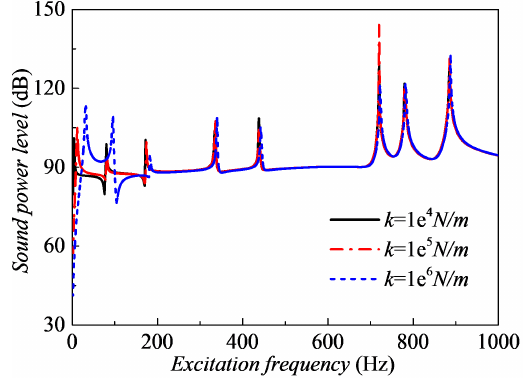
Figure 10: The comparison of sound poewr level with C-C-C-C bound- ary condition